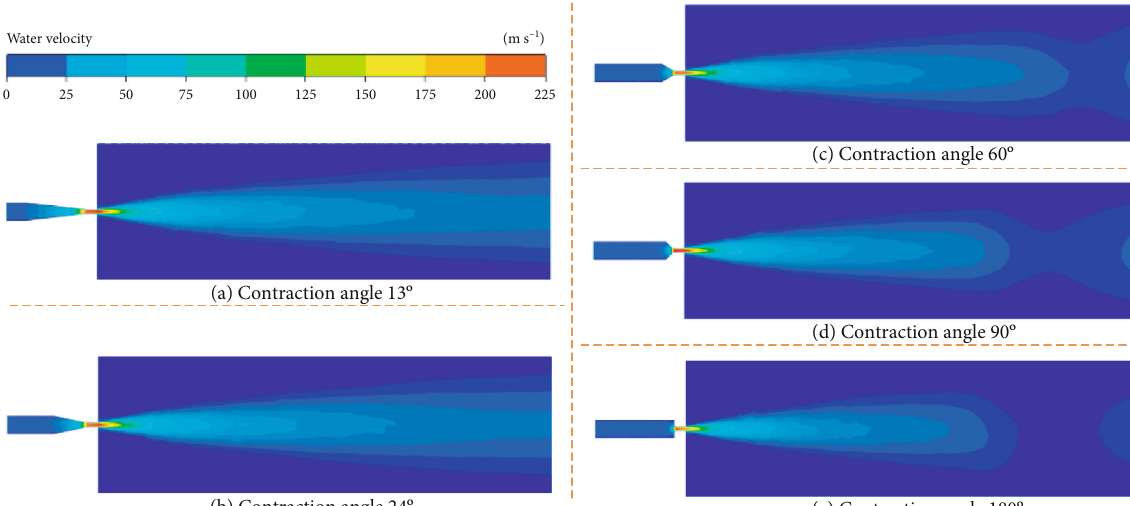
Figure 8: Contour maps of jet velocity formed by nozzles with di ff erent contraction angles.